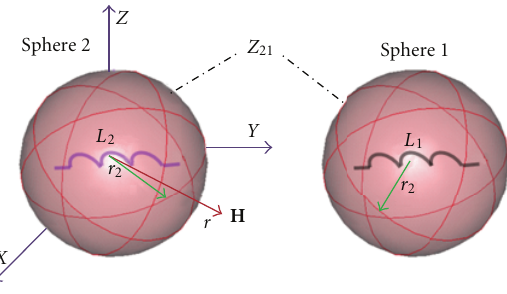
Figure 10: Representation of two radiating sources.